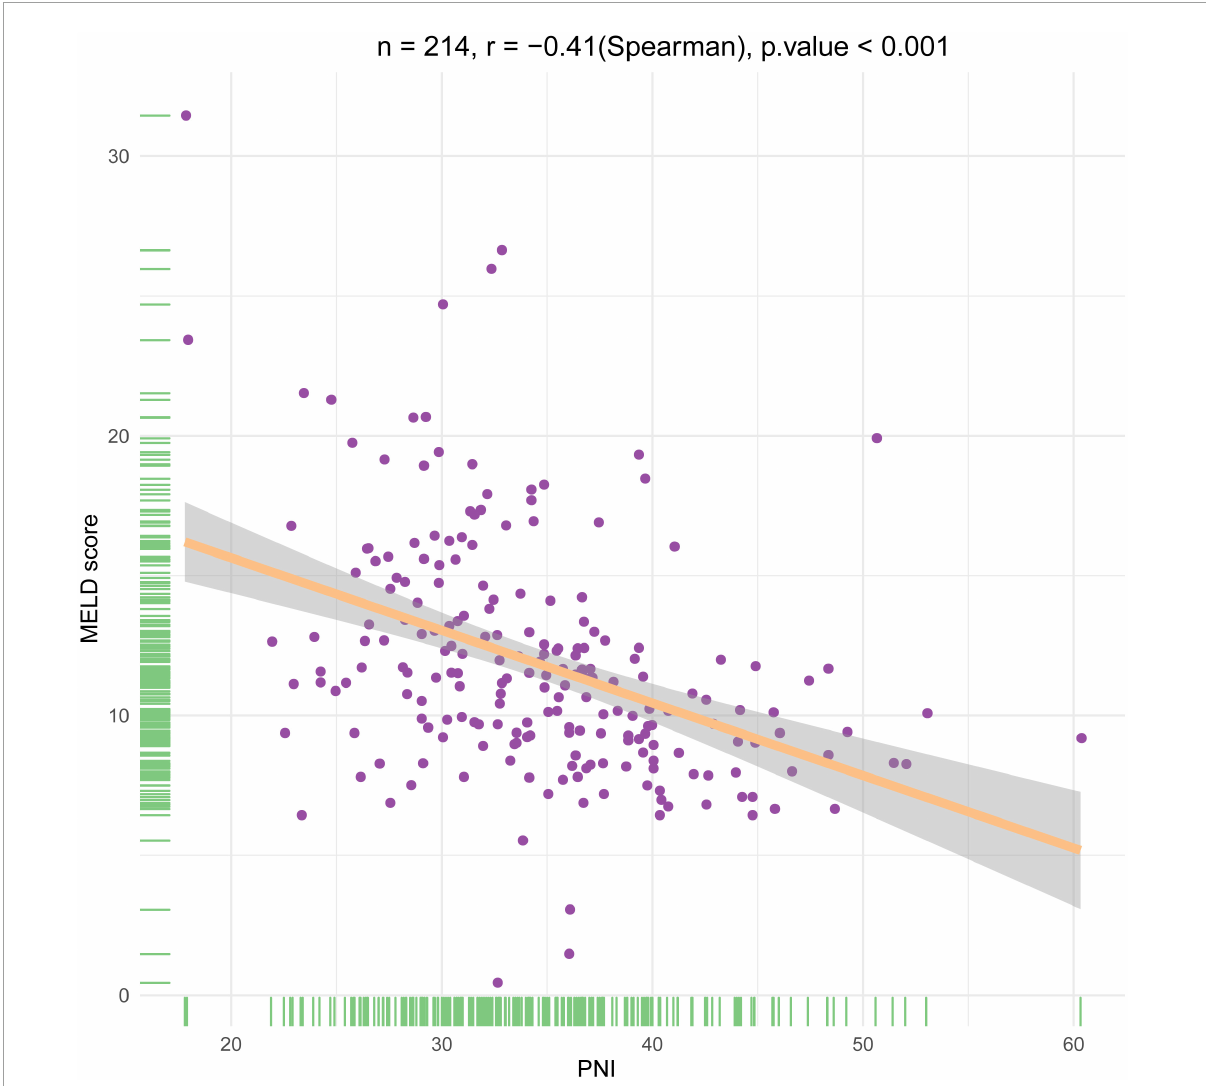
FIGURE1 Scatter graphs illustrating the association between the prognostic nutritional index and the MELD